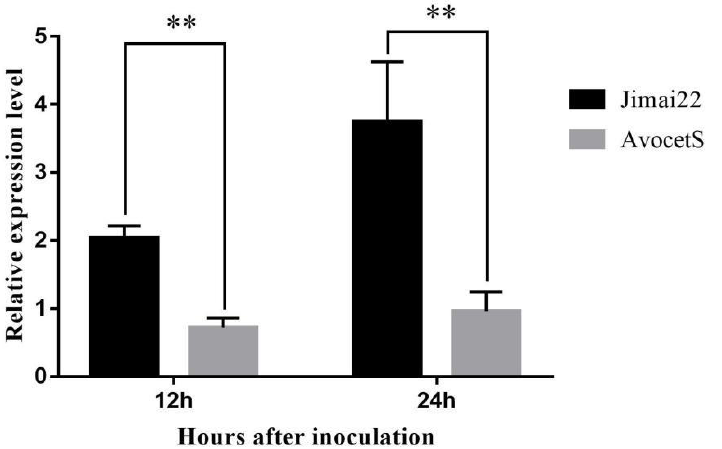
Figure 6. qPCR analysis of the candidate gene TraesCS2A01G573200 in Jimai 22 and Avocet S at 12 and 24 h after inoculation with CYR32. **, significant difference at p < 0.01, based on Fisher’s least significant difference